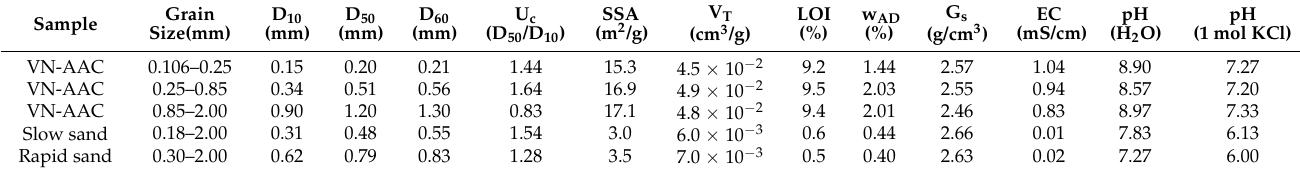
Table 1. Basic physical and chemical properties of tested samples in this study.